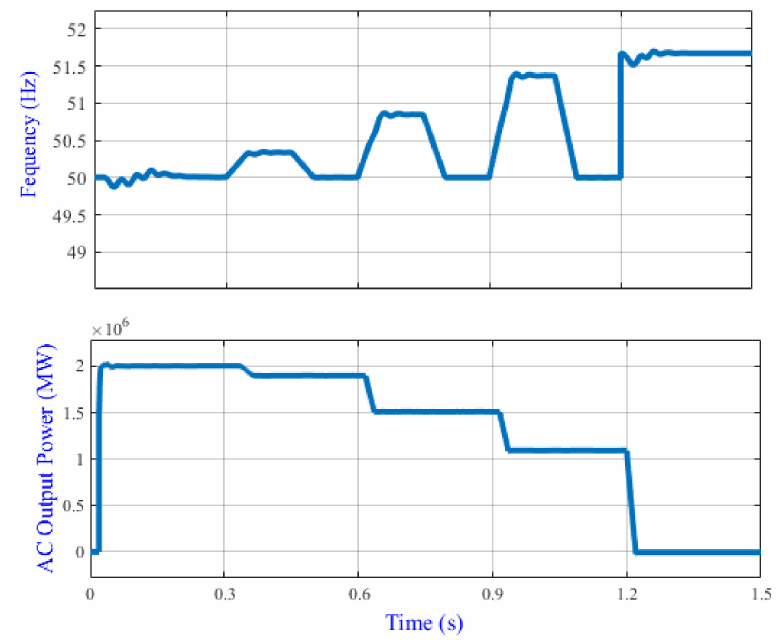
Figure 17. Active power control behavior during different levels of frequency